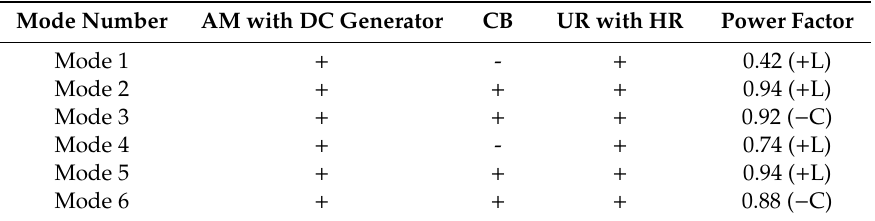
Table 4. The modes of laboratory